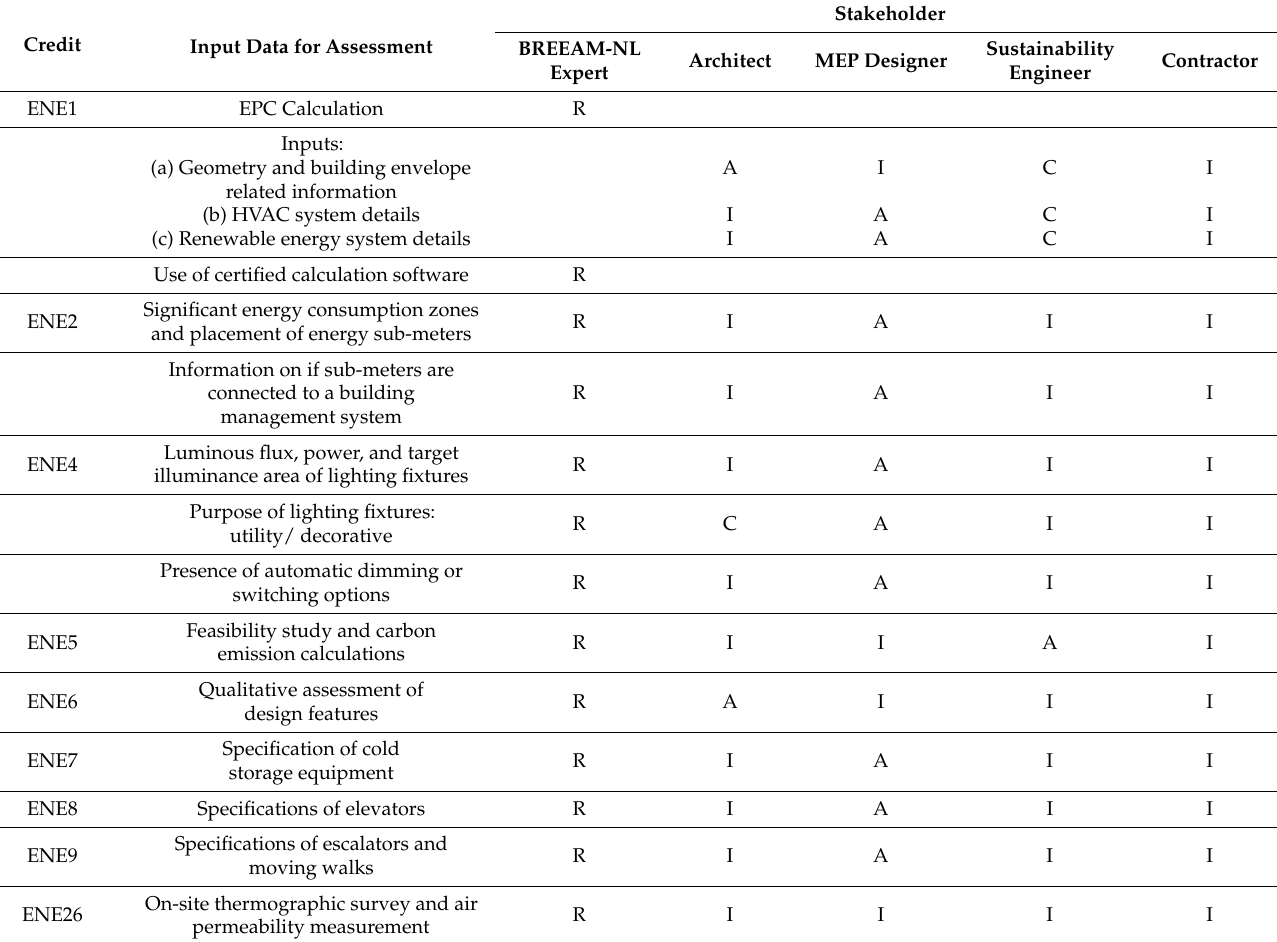
Table 5. BREEAM-NL energy credits vs. stakeholder